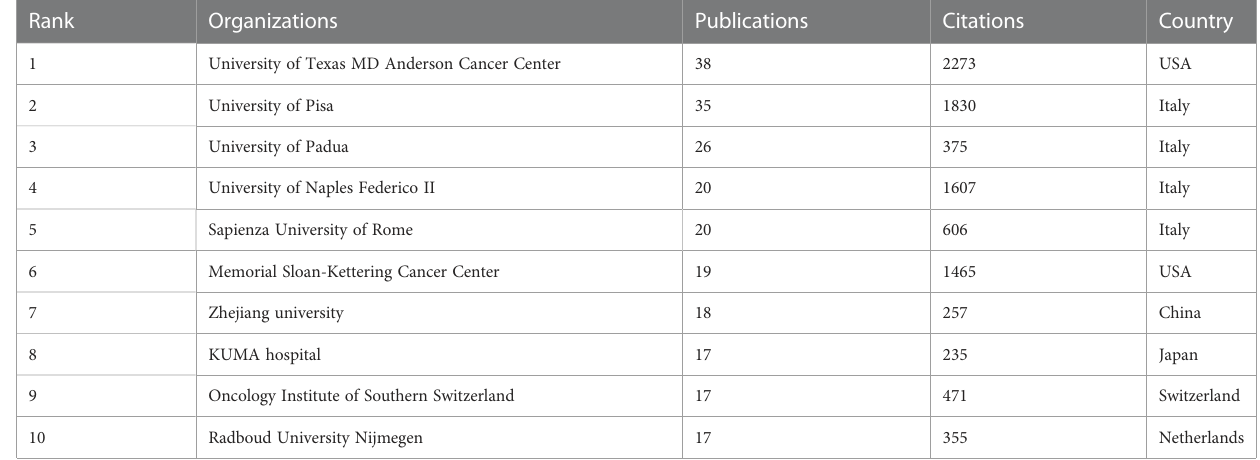
TABLE 2 Top 10 organizations in the MTC research fi eld.